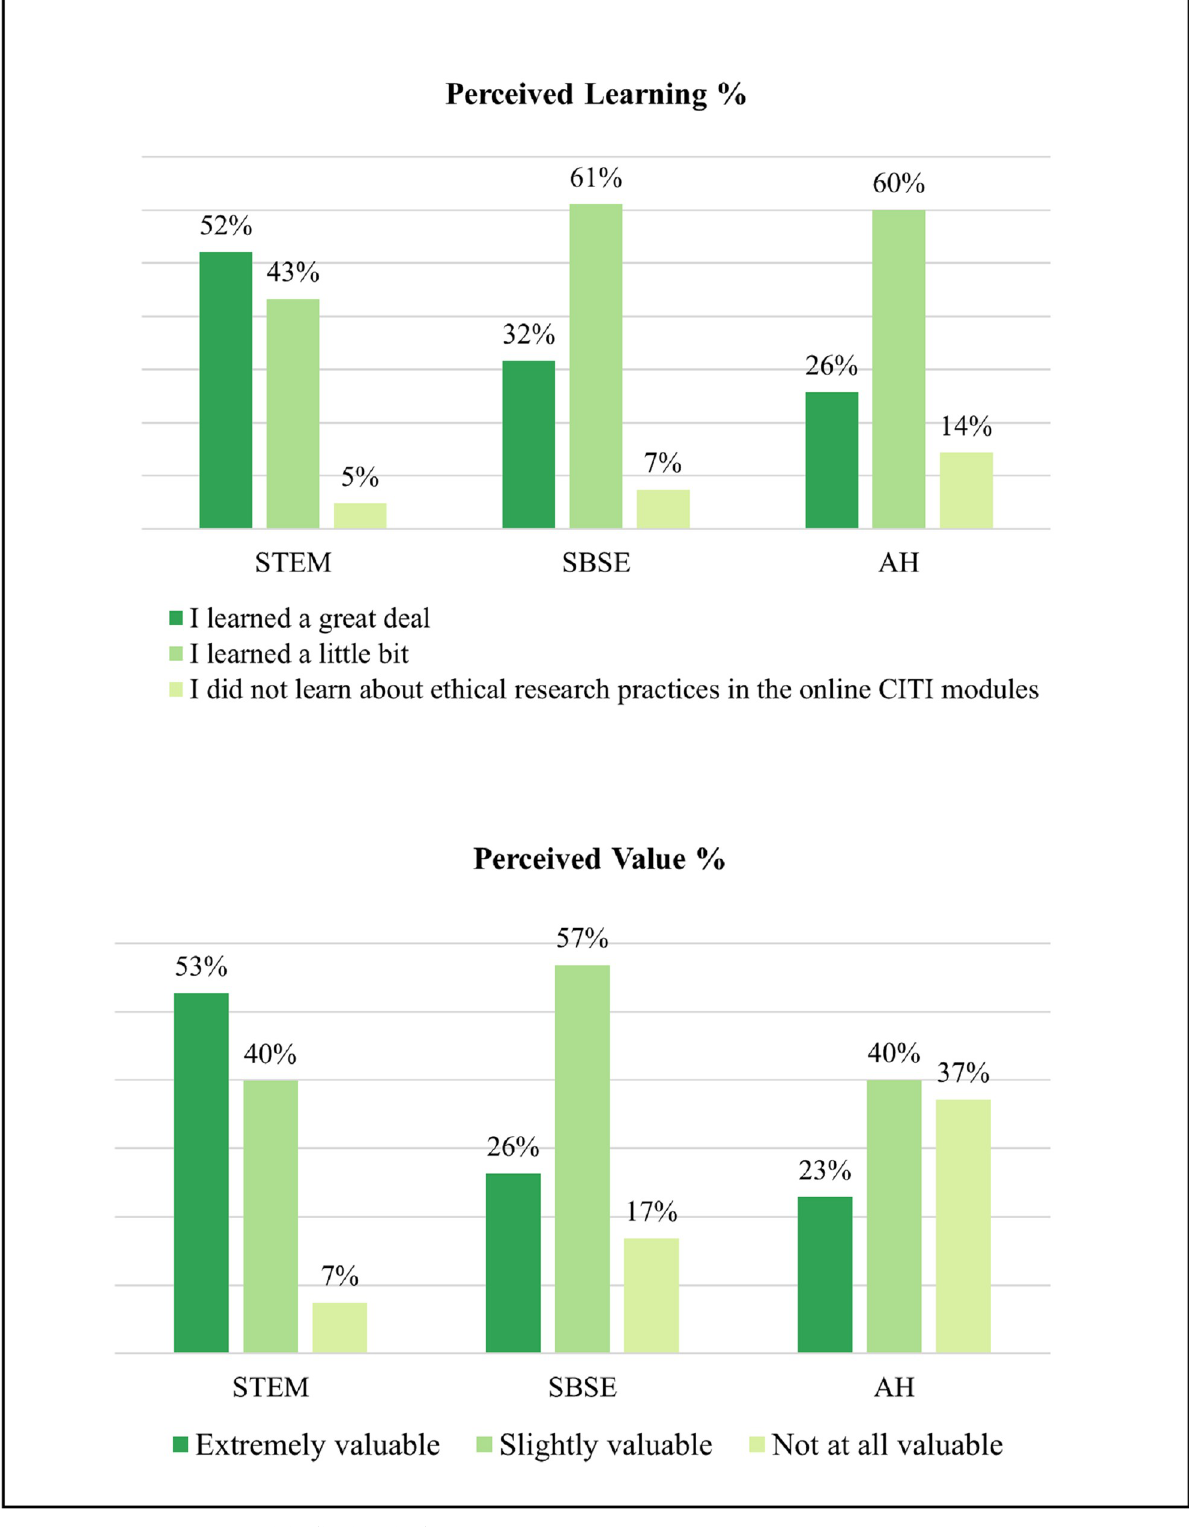
Fig 3. Stage 1: CITI training modules (by discipline).